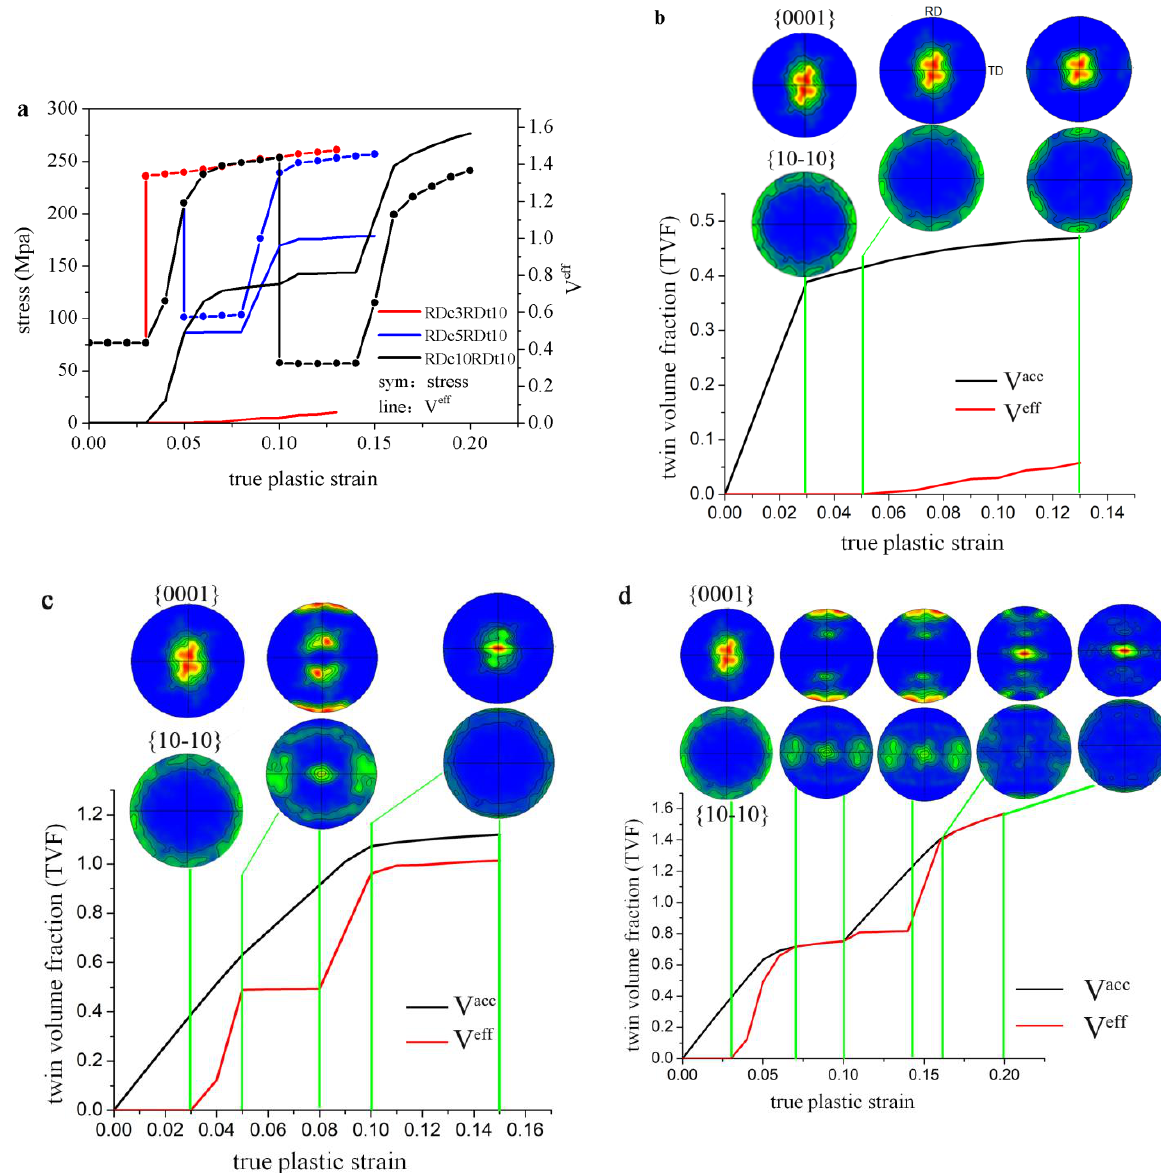
Fig. 7. (a) Flow stress and effective twin volume fraction (TVF), texture evolution combined with accumulated and effective twin volume fraction in (b) RDc3RDt10, (c) RDc5RDt10 and (d)